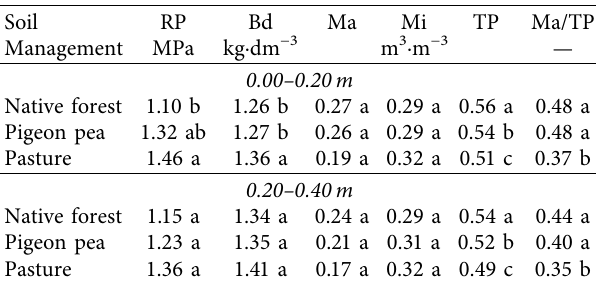
Table 2: Mean values of soil resistance to penetration (RP), soil bulk density (Bd), macroporosity (Ma), microporosity (Mi), total porosity (TP), and macropore density (Ma/TP) in Archaeological Dark Earth (ADE) areas receiving three different management